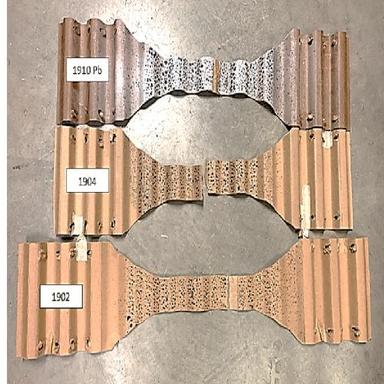
The failure of various corrugated panels under transverse tensile loading.